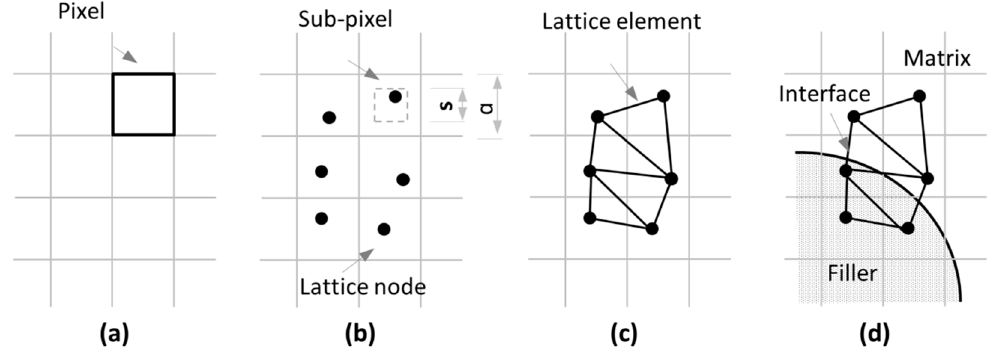
Figure 1. Schematics of microstructure generation [19]. ( a ) Pixel generation; ( b ) node placement; ( c ) element generation; ( d ) overlay procedure.